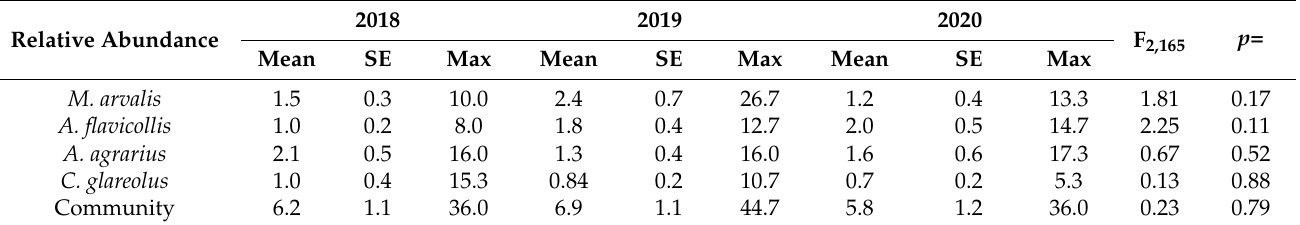
Table 2. Relative abundances (individuals per 100 trap-days) of the small mammal communities and the most numerous species in commercial orchards, 2018–2020. Based on ANOVA F and Tukey’s HSD, no differences between years were significant.